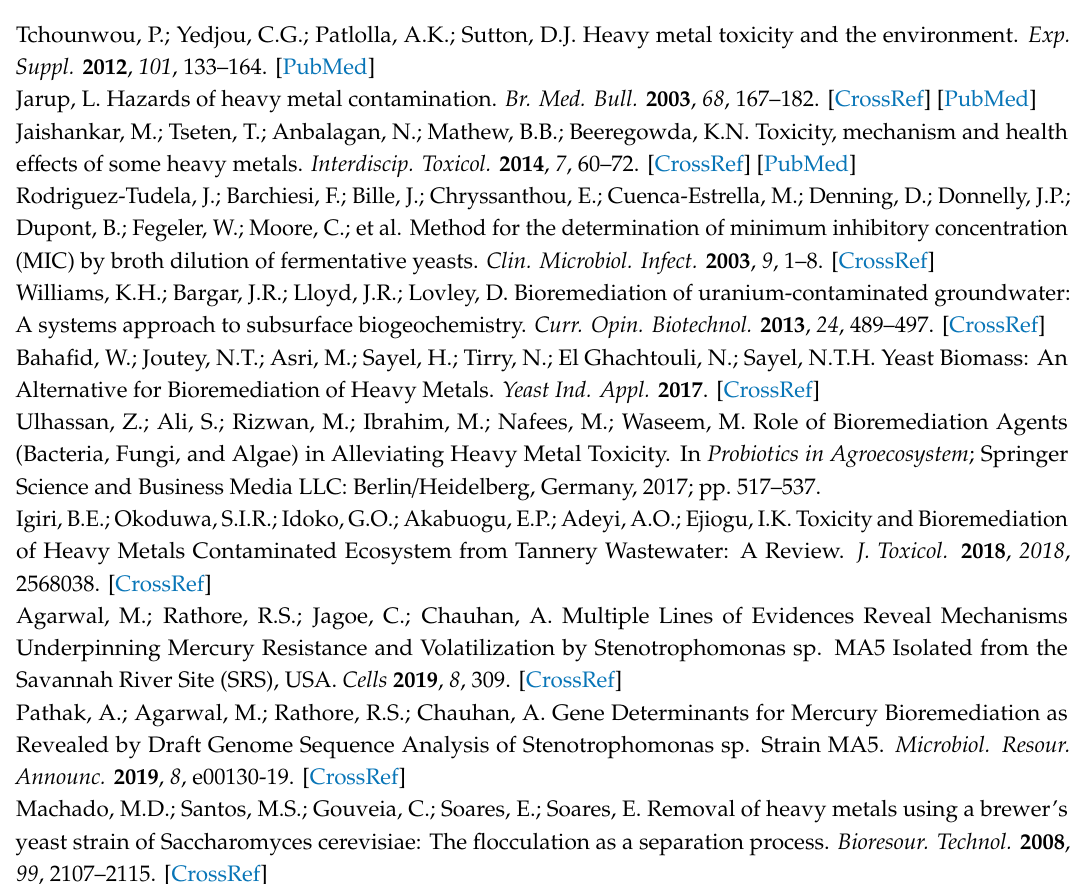
Table S1: Shown are MIC levels of di ff erent microbial isolates along with their susceptible concentration values against